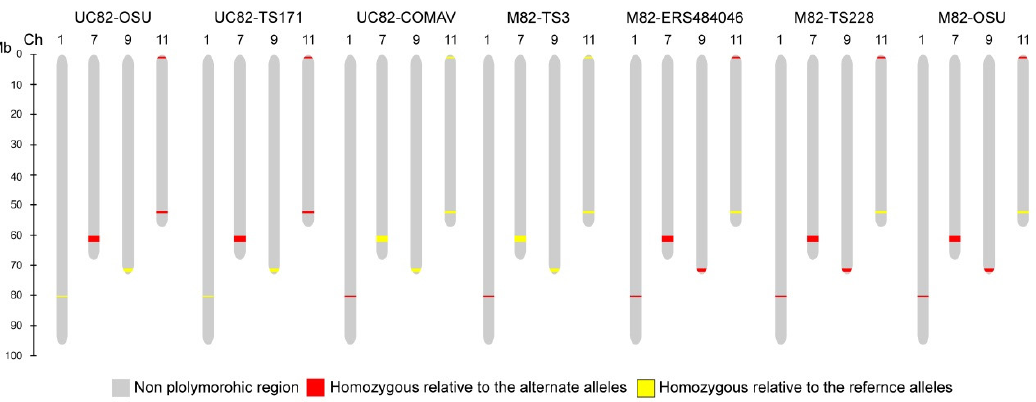
Figure 3. Schematic representation of the differential chromosome regions between ʻ UC 82 ʼ and ʻ M82 ʼ ‘M82’ accessions.